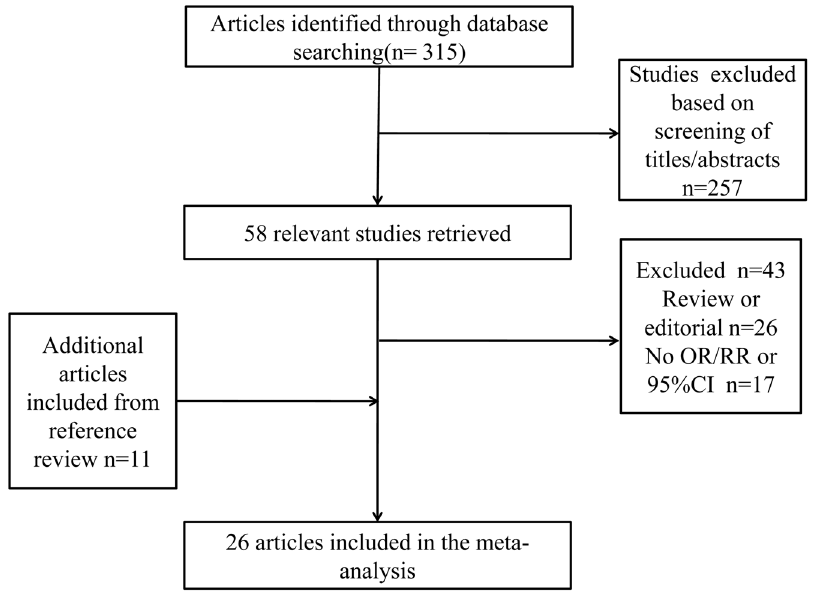
Figure 1. Flow chart of the included studies.